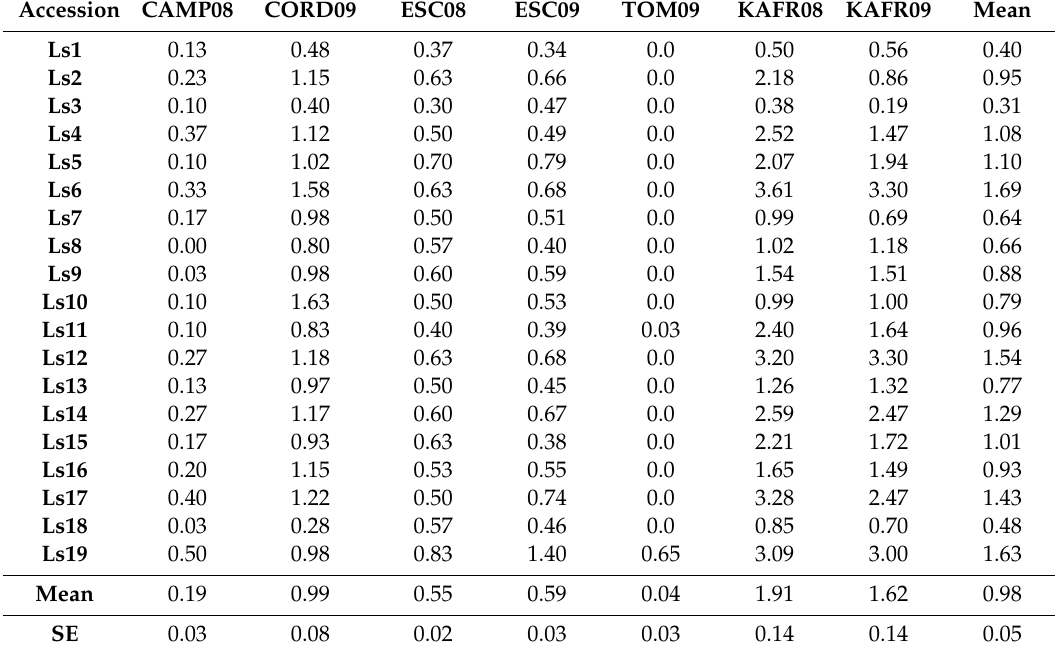
Table 3. Number of broomrapes per plant of 19 grass pea accessions grown at 7 location–year environments.